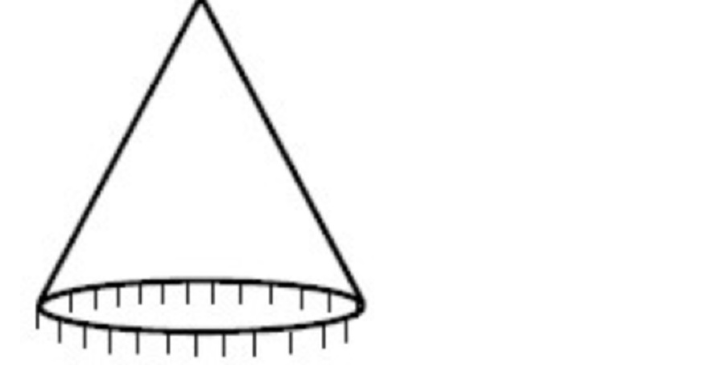
Figure 35 . A half (cid:12)gure conformally transformed from (cid:12)gure 34. We can scale up or down by changing the length of the edge with the objects attached to